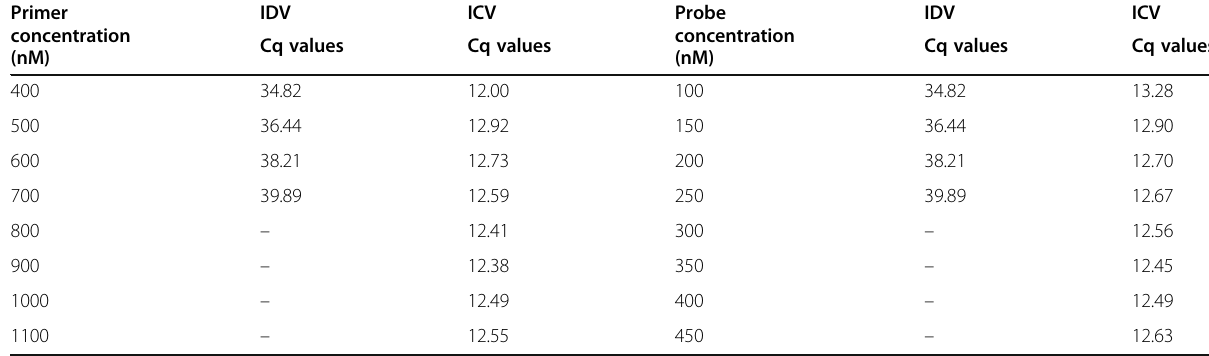
Table 1 ICV and IDV detected by duplex real-time PCR assay using different primer concentrations